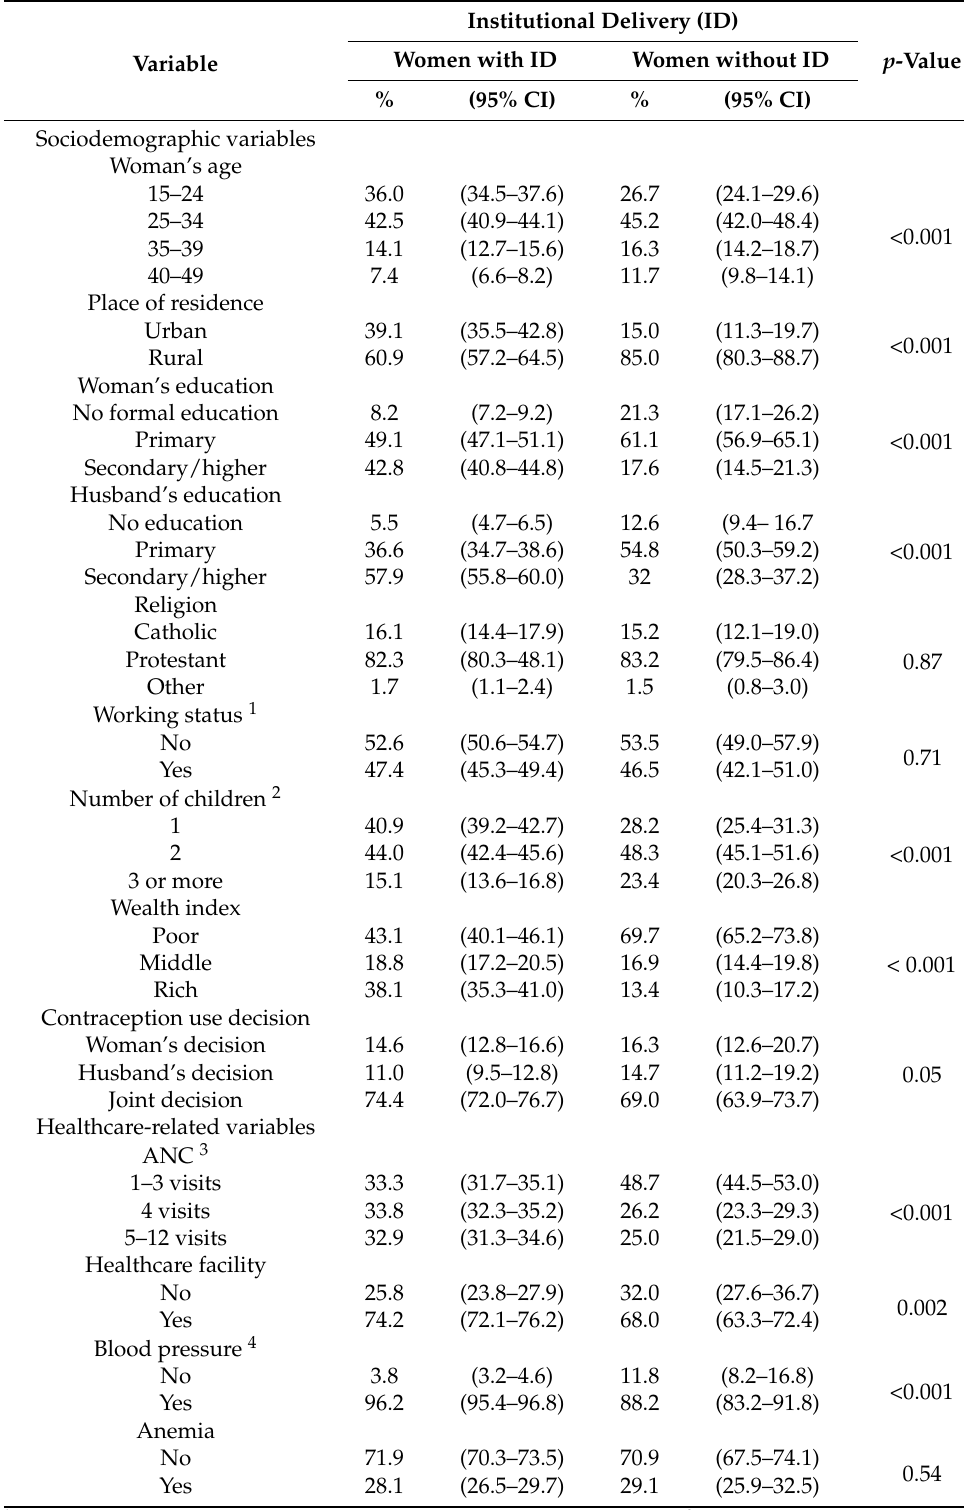
Table 2. Characteristics of women with and without institutional delivery across the explanatory variables ( n =